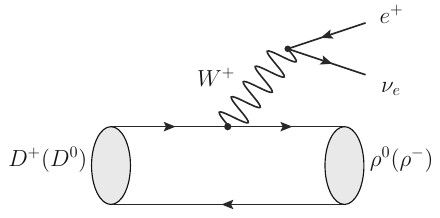
Fig. 1 Typical diagram for the D → ρ e + ν e semileptonic decay